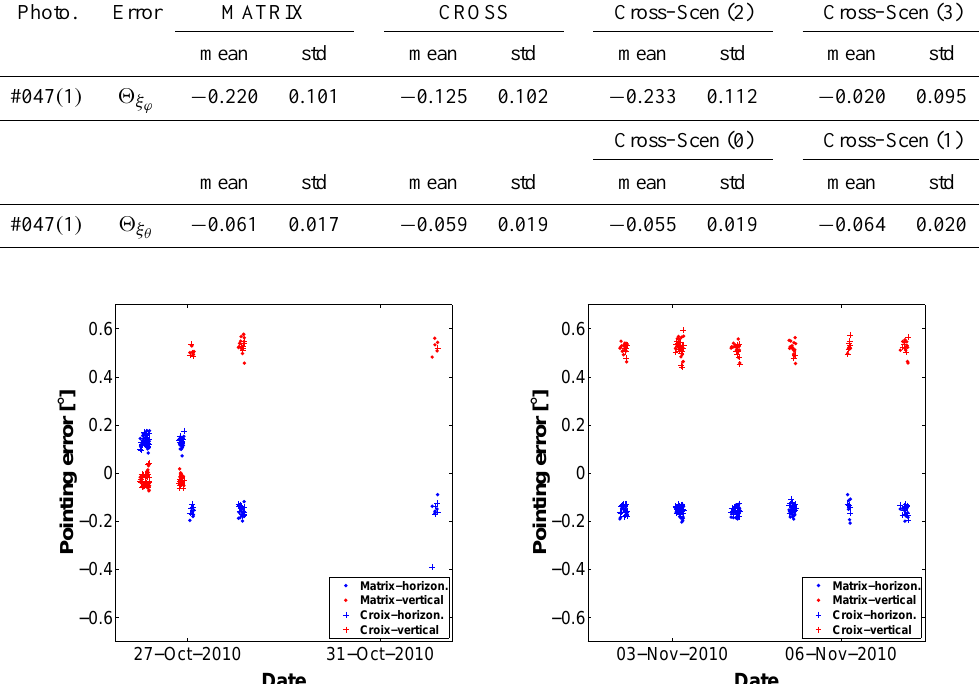
Table 4. Summary of the horizontal pointing error ( 2 ξ photometer #047.